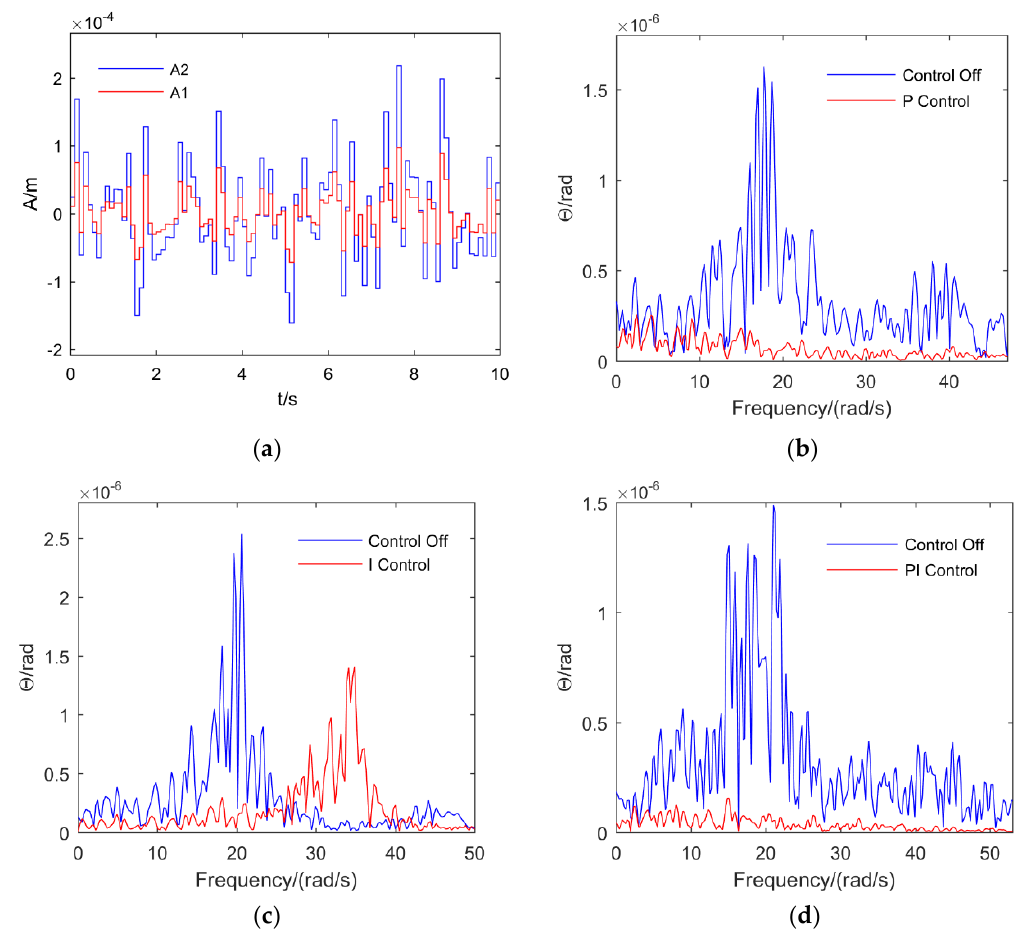
Figure 17. Comparison of the peak values of output light angle response of the spatial filter under the control and non-control of broadband white noise: ( a ) Displacement excitation signal of broadband white noise; ( b ) velocity feedback gain g P control; ( c ) displacement feedback gain g I control; ( d ) velocity feedback gain g P and displacement feedback gain g I joint control.